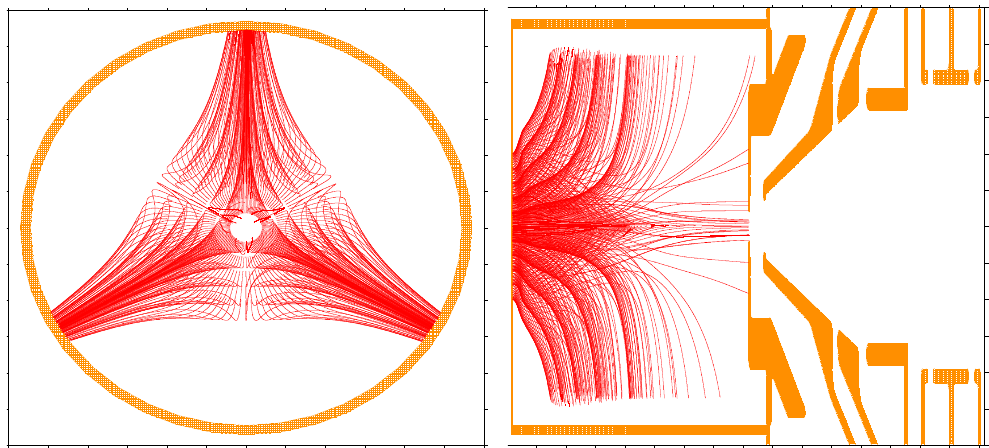
200V. Left: cut perpendic- −